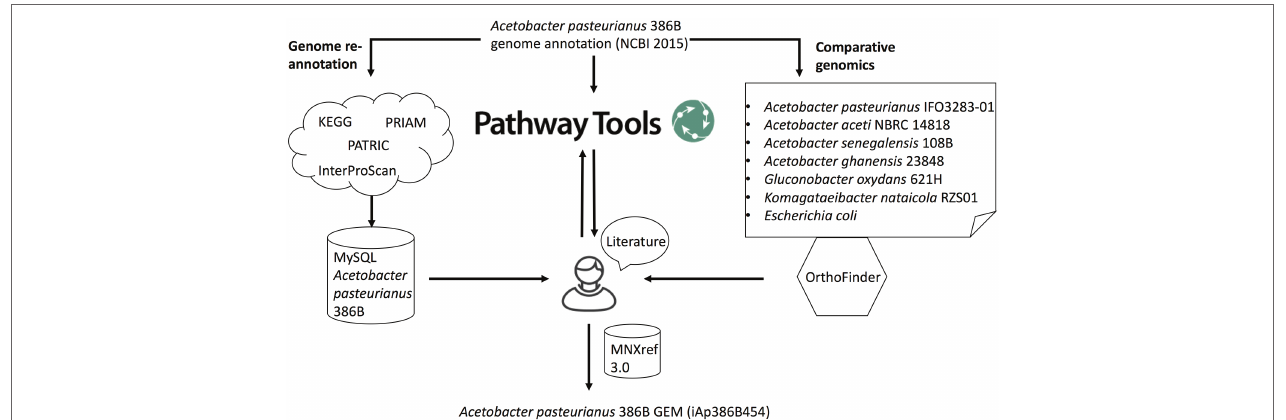
FIGURE 1 | Schematic overview of the metabolic network reconstruction process. Genome re-annotation of A. pasteurianus 386B was performed using a combination of several databases ( e.g. KEGG, PATRIC) and tools (e.g., PRIAM, InterProScan). Functional annotations were stored in a MySQL database. Comparative genomics using OrthoFinder allowed to identify orthogroups of protein sequences between A. pasteurianus 386B and other phylogenetically related bacterial species. Pathway Tools was used to predict metabolic pathways as well as the reactions and gene-protein-reaction associations that constitute these pathways. This information was stored in a Pathway/Genome database (PGDB). Edges entering the human curator node represent the information sources that were used to guide manual curation. Using additional information from the literature, the A. pasteurianus 386B PGDB was curated and its information transferred